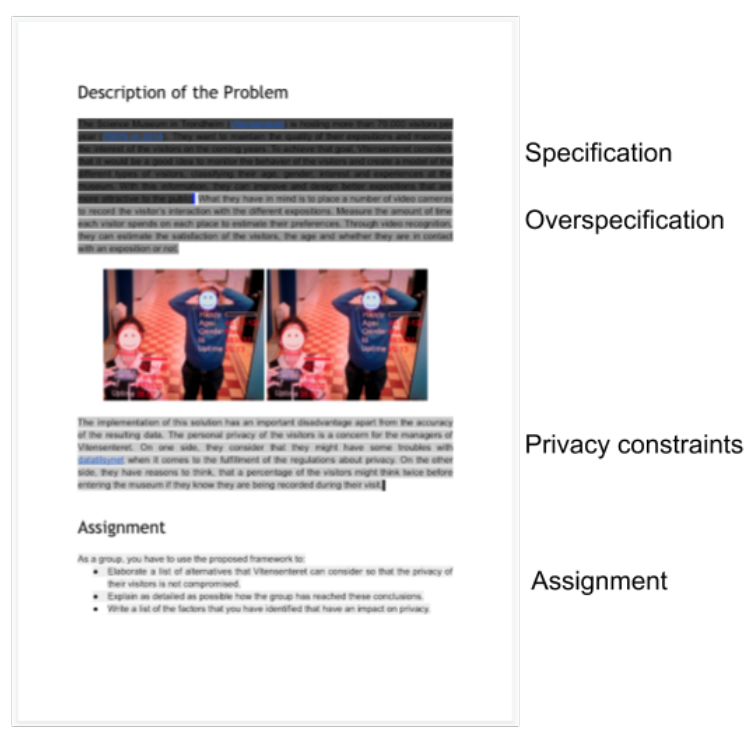
Figure 1. Structure of the problem